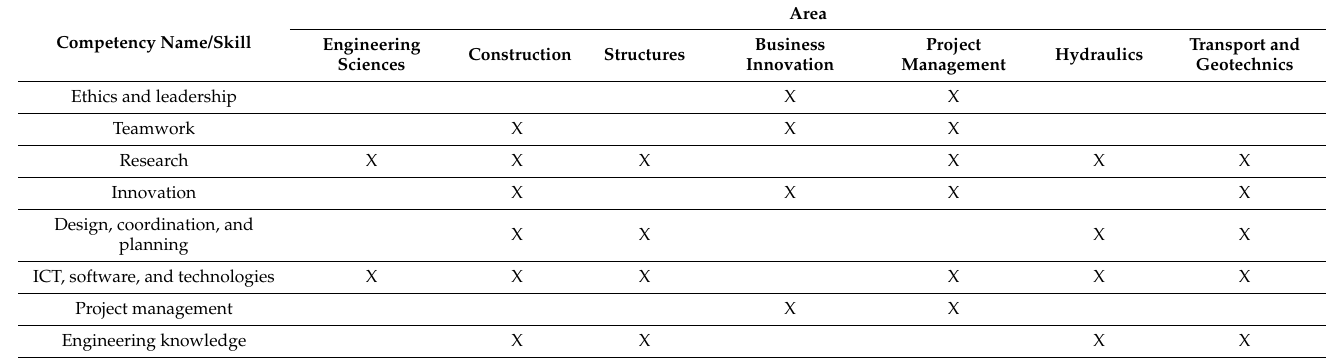
Table 8. Interrelationship matrix between training areas and competencies from the civil engineering program.